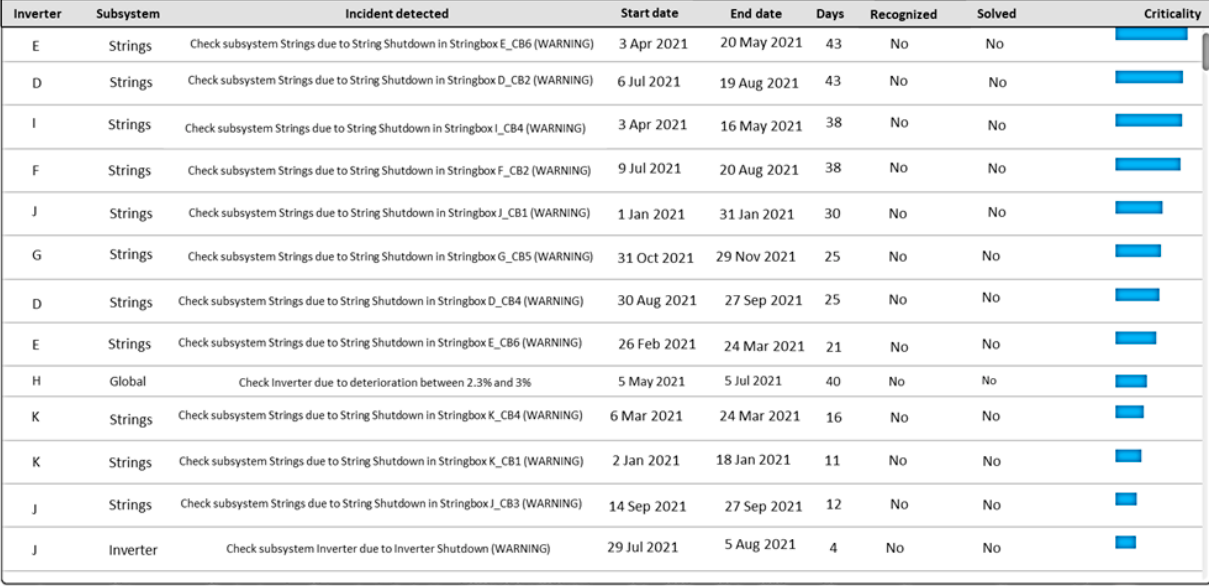
Figure 21. Screenshot depicting some of the O&M recommendations generated by the DSS engine, along with the criticality value assignation for the detected incidents.